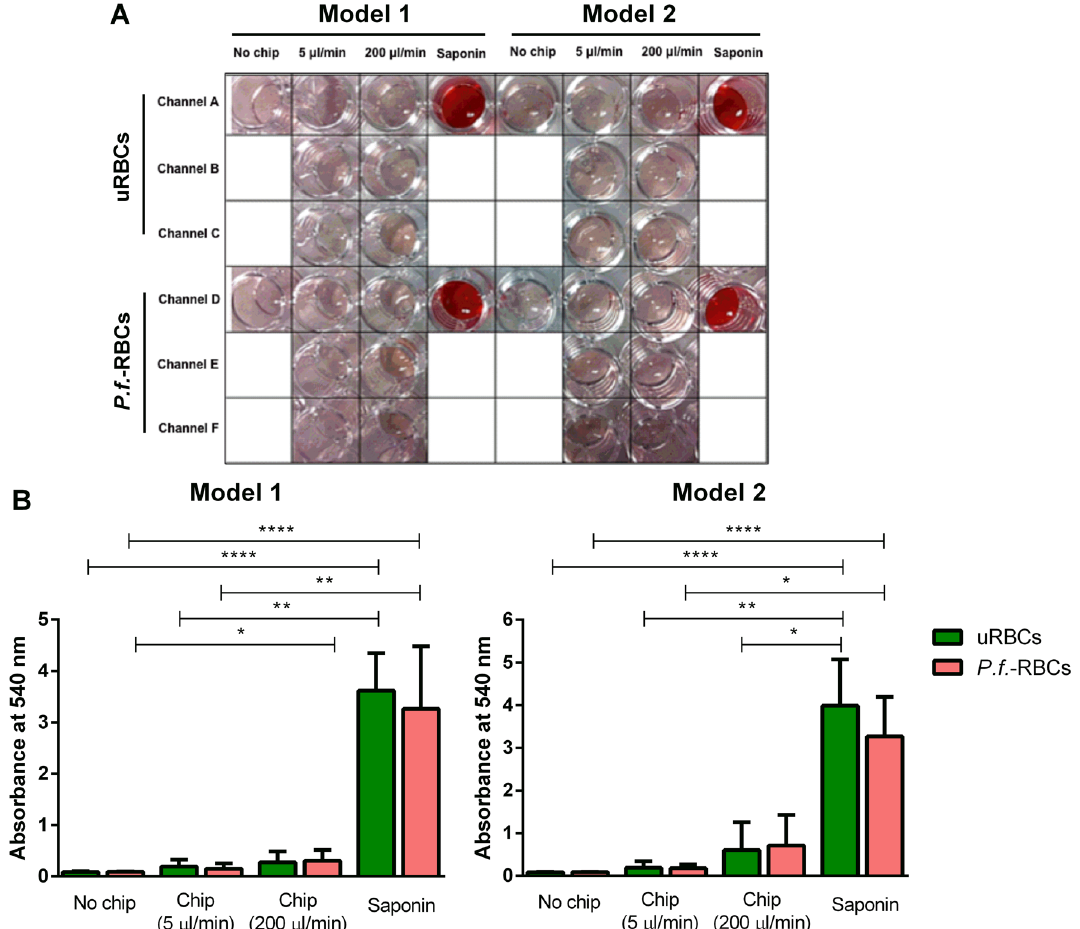
Figure 4. Hemolysis quantification of RBCs after passage through the microdevices. ( A ) Different conditions of the hemolysis assay with a picture of the 96-well plate containing the supernatants of the different samples. Data correspond to one representative experiment. ( B ) Hemolysis quantification of RBCs. Plots show the mean and the standard error of supernatant absorbance values of uRBCs and P.f.- RBCs that passed through model 1 and model 2. Data correspond to all experiments performed through the study. Statistical significance was determined using the Kruskal–Wallis test. Dunn’s multiple comparisons test showed the following results (**** p ≤ 0.0001; *** p ≤ 0.001; ** p ≤ 0.01; * p ≤